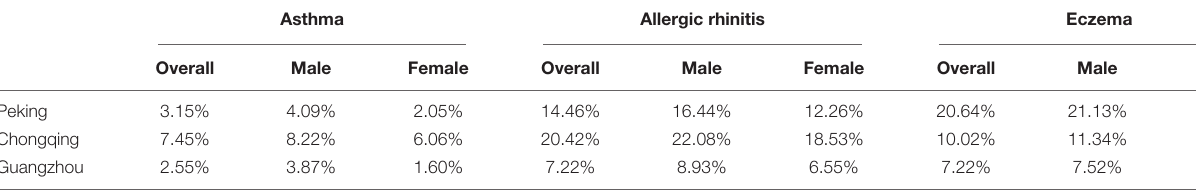
TABLE 1 | Incidence of allergic diseases in children of different cities and genders (Zhao et al., 2011). Asthma Allergic rhinitis Eczema Overall Male Female Overall Male Overall